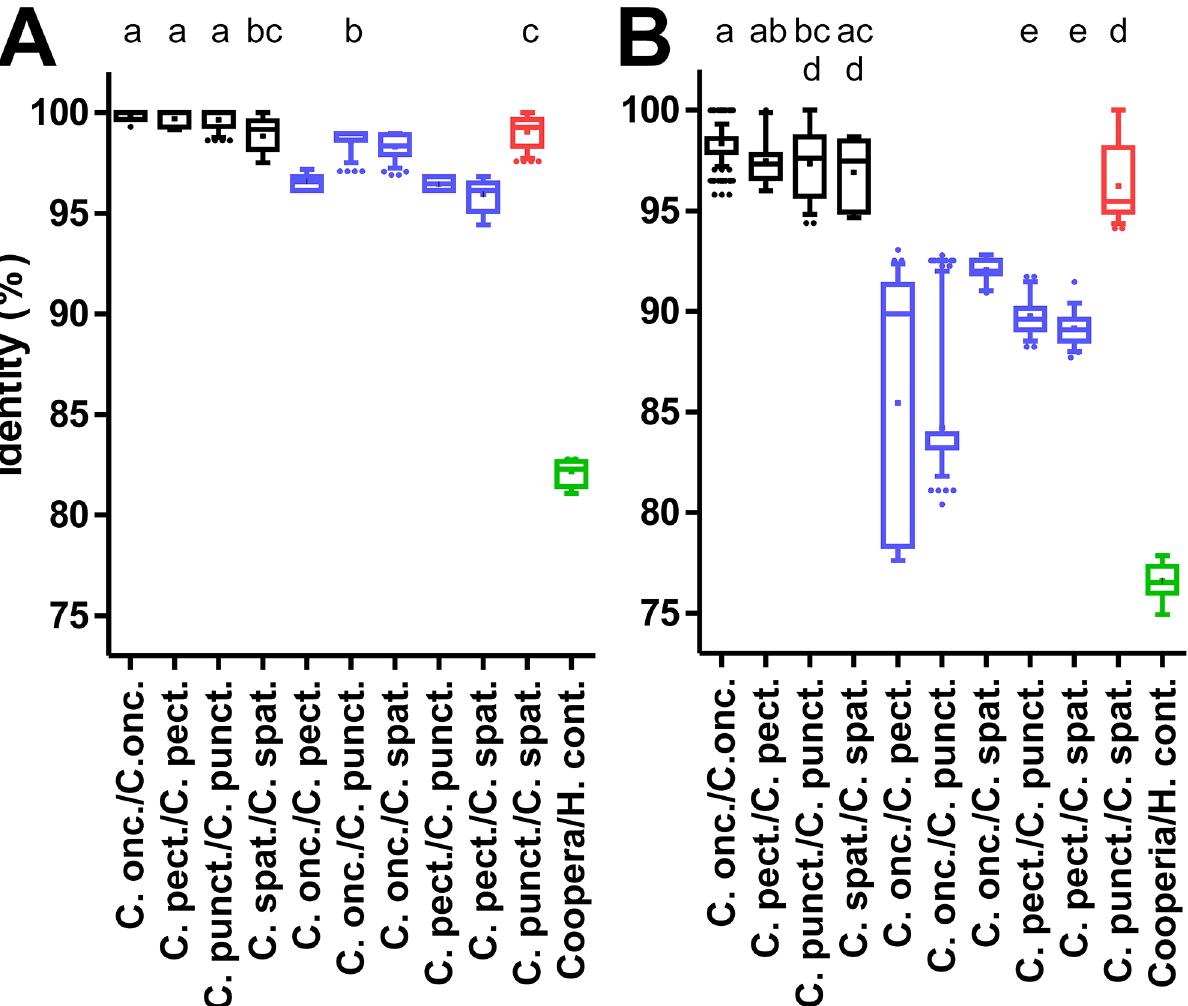
Fig 3. Pairwise sequence identities for intra- and inter-species comparisons for nuclear ITS-2 and isotype 1 β -tubulin loci. Identities were calculated from multiple sequence alignments for the ITS-2 region (A) and a partial genomic isotype 1 β -tubulin gene containing two introns (B). Data are presented as box plots showing the median and 25 and 75% percentiles. Whiskers represent 5–95% quantiles and outliers are represented by dots while the cross indicates the mean. Intra-species comparisons are shown in black, inter-species comparisons within the genus Cooperia in blue, comparisons between C . punctata and C . spatulata in red. All comparisons between a Cooperia sequence and a representative H . contortus sequence are indicated in green. Accession numbers for all sequences that were included in the analysis are available from S2 Table. Datasets that do not share at least one of the index letters (a-c in panel A and a-e in panel B) are significantly different (p < 0.05) from each other in a Kruskal-Wallis test followed by a Dunn’s post hoc test between all Cooperia groups.